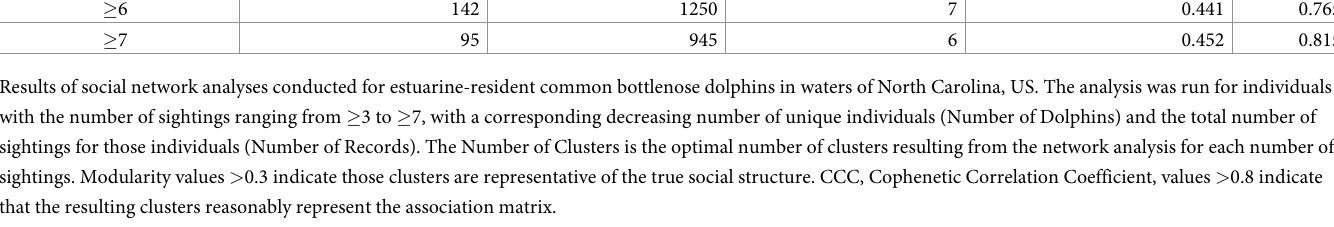
The overall mean association index was low (HWI = 0.04, SD = 0.02) however the maxi- mum association indices indicated the existence of strong dyadic associations (mean 0.45, SD = 0.21, range 0.10–0.95) (S3 Fig). The sum of association indices, which approximately indicates the number of associates [77], ranged from 1.1–8.64 (mean 4.8, SD 1.84). Social dif- ferentiation (S) was 0.905, indicating a well differentiated social system. The mean association per individual (H) was 36.6, resulting in S2 � H = 29.95 (above the threshold of five to reject the null hypothesis of no preferred associates). The correlation coefficient (r) between true and permuted association indices was moderate (r = 0.408). For the test for preferred or avoided associations, P-values were relatively stable from 1,000–30,000 permutations, changing only from p = 0.001 to p < 0.001 for all levels of permutations; hereafter we used values from 10,000 permutations. The existence of long-term non-random associations (preferred or avoided) was supported by a significantly higher SD (0.109 vs 0.089, p < 0.001) and CV (0.656 vs 0.574, p < 0.001) from observed than from permuted data, respectively; avoidance of associations was muted data (0.221 vs 0.258, respectively).